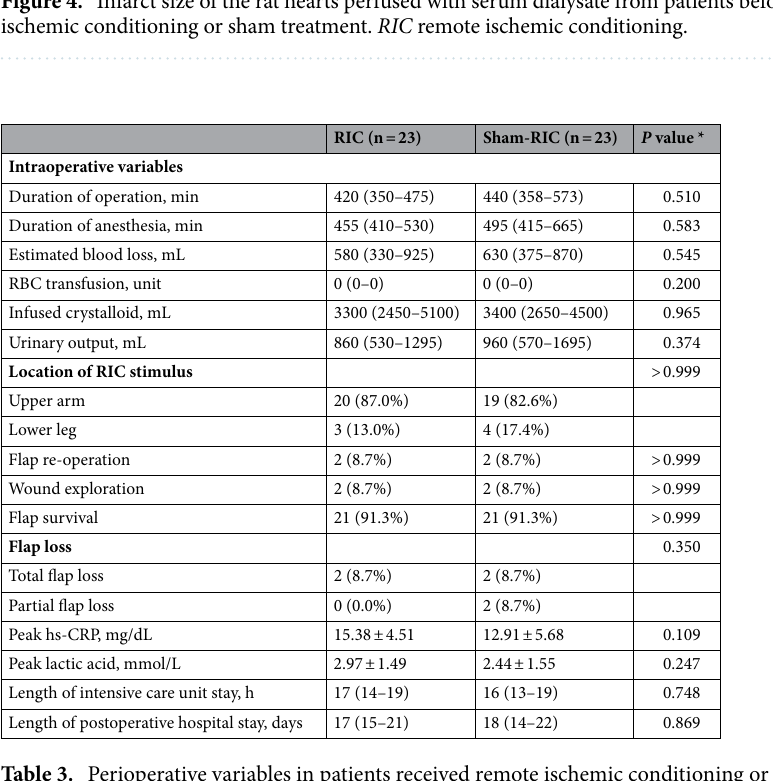
Table 3. Perioperative variables in patients received remote ischemic conditioning or sham during free flap reconstructive surgery for head and neck cancer. Values are median (IQR), number (proportion), or mean ± SD. RIC remote ischemic conditioning, RBC red blood cell, hs-CRP high sensitivity C-reactive protein. * P value between the RIC and sham-RIC